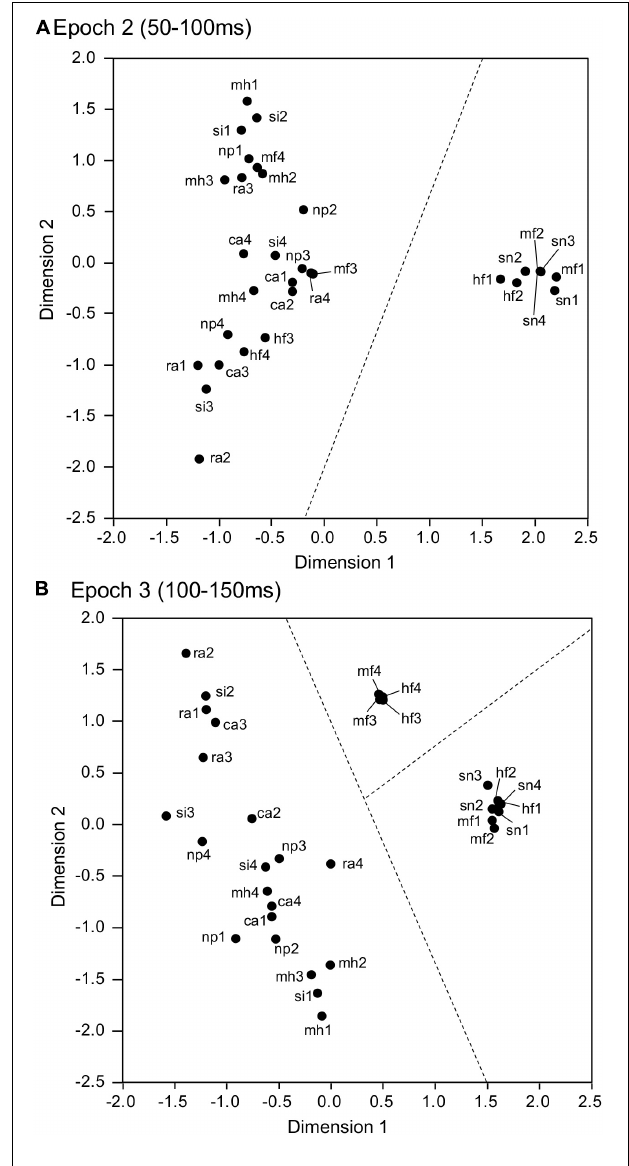
FIGURE 6 | Representation of the 32 visual stimuli in a 2D space resulting from MDS using responses of the 95 amygdalar neurons to these stimuli. (A) Representation in epoch 2. The snakes (sn1-4) and emotional faces (mf1-2 and hf1-2) were separated from the remaining stimuli. (B) Representation in epoch 3. Three groups were separated: group 1 (snakes and emotional faces: sn1-4, mf1-2, and hf1-2), group 2 (neutral faces: mf3-4 and hf3-4), and group 3 containing the remaining